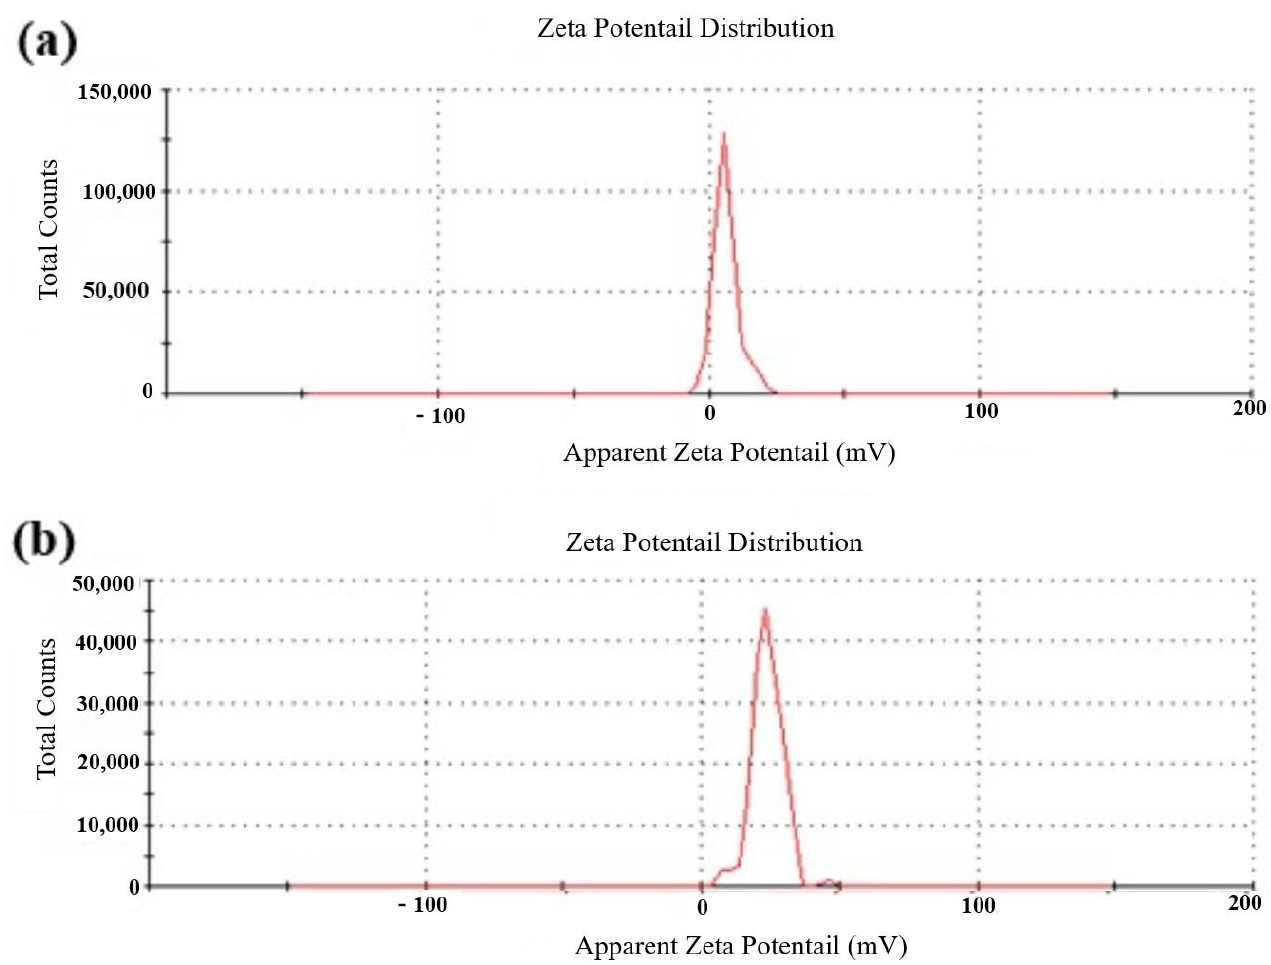
Figure 7. Particle size analysis of Metarhizium anisopliae conidia ( a ), and M. anisopliae – chitosan nanoparticles ( b ).